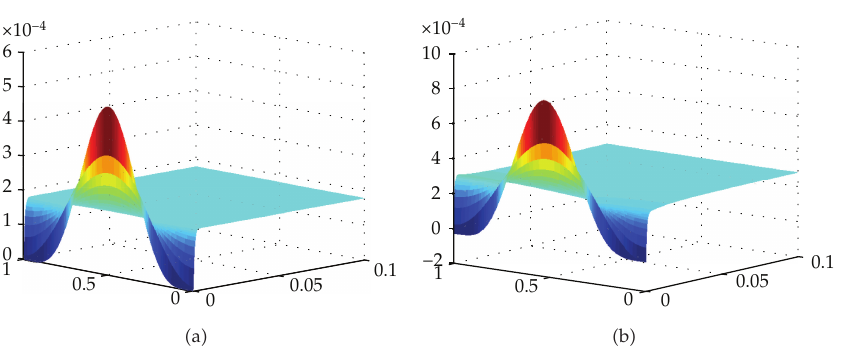
Figure 1: The development of the solution of the full-discrete scheme when initial value is u 0 (cid:7) x (cid:8) (cid:9) x 5 (cid:7) 1 − x (cid:8) 5 (cid:7) a (cid:8) and u (cid:7) x (cid:8) (cid:9) x 5 (cid:7) 1 − x (cid:8) 5 e x (cid:7) b (cid:8) . 0